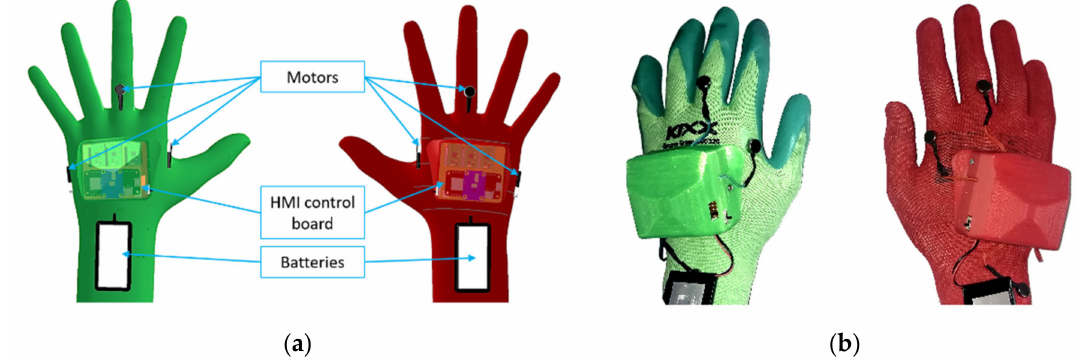
Figure 1. Prototype of HMI: ( a ) 3D model of HMI prototype, HMI cover is set as translucent in order to visualise the internal placement of the components; ( b ) implemented